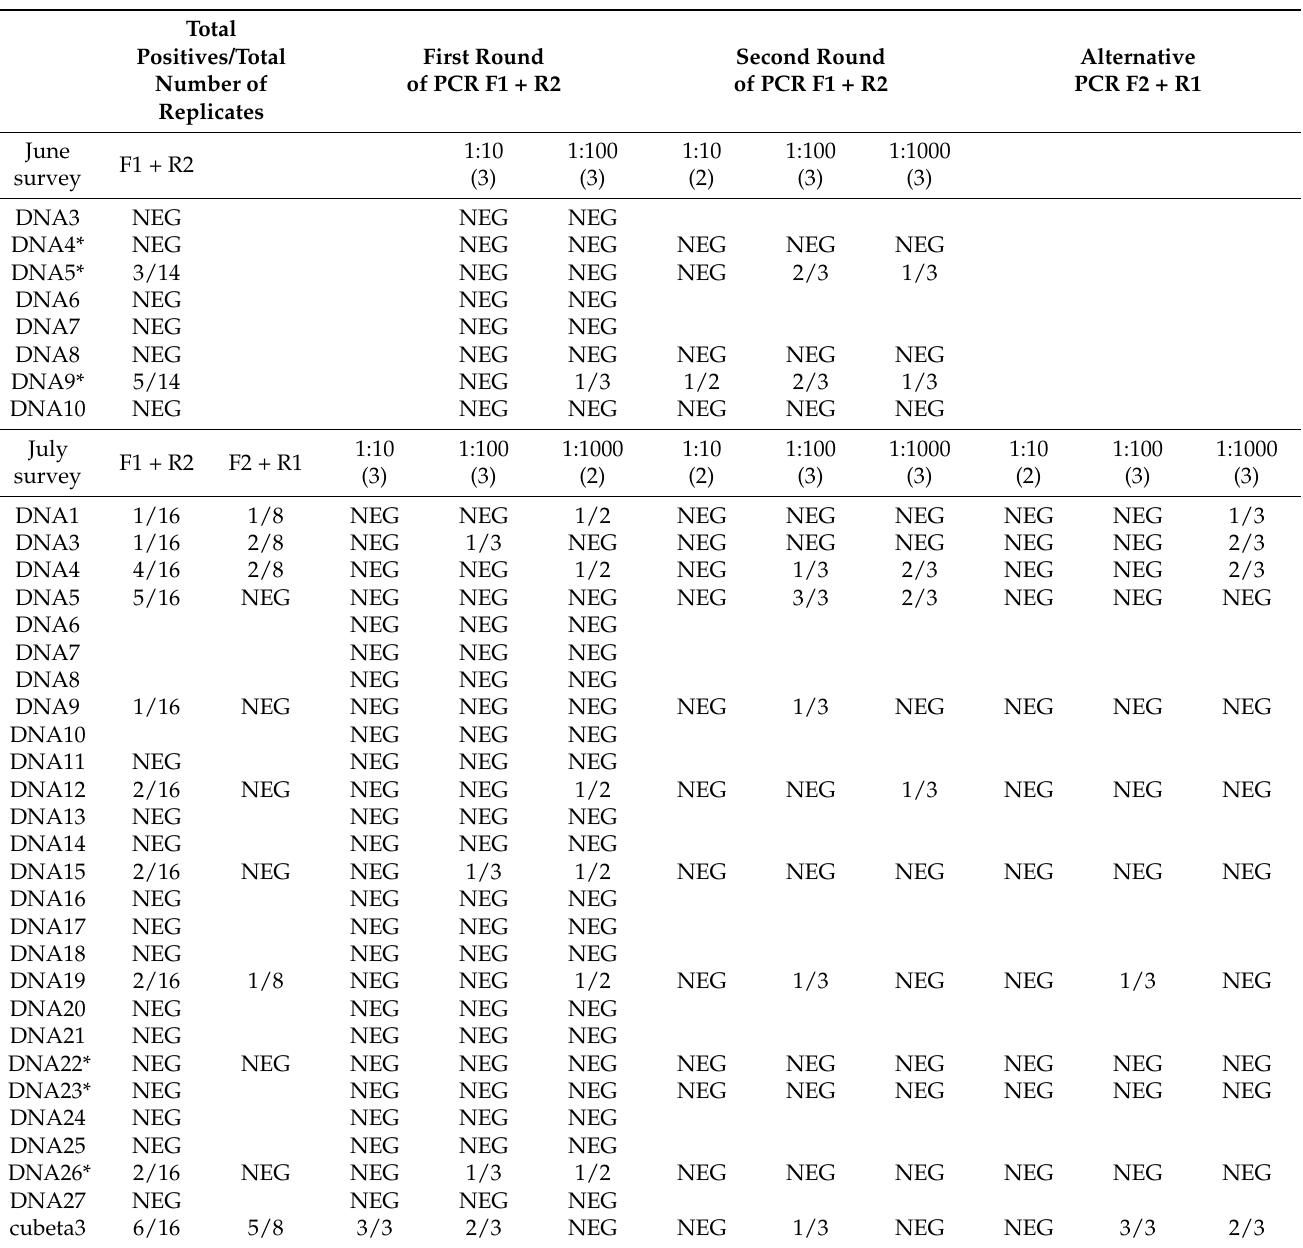
Table 3. Number of positive replicates for the specific amplification of American bullfrog eDNA with respect to the total number of replicates, in samples from the 2020 surveys. NEG: no amplification. The number of replicates for each tested dilution (1:10, 1:100, 1:1000) is indicated between parenthesis. F1 + R2 means that PCRs were performed with the cytbF1 and cytbR2 primer set. F2 + R1 means that PCRs were performed with the alternative set of primers cytbF2 + cytbR1. All specific amplifications were validated with positivity in the amplifications with amphibian universal primers in the first or second round (samples that were amplified at the second round via universal PCRs are indicated with an asterisk (*)). Note: In the June survey, a second round of the specific PCR was performed also in DNA10, because it was in this location that the adult individual was found. In the July survey, we included DNA9 in the second round of the specific PCR because it resulted in a positive in the June survey.